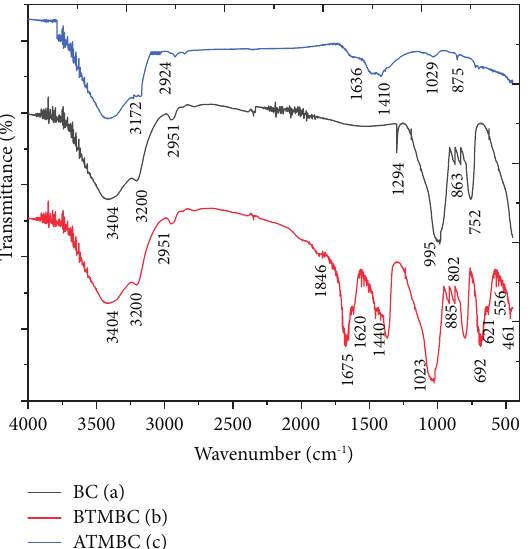
Figure 3: FTIR analysis for biochar, modified Teff straw biochar, and modified biochar treatment.